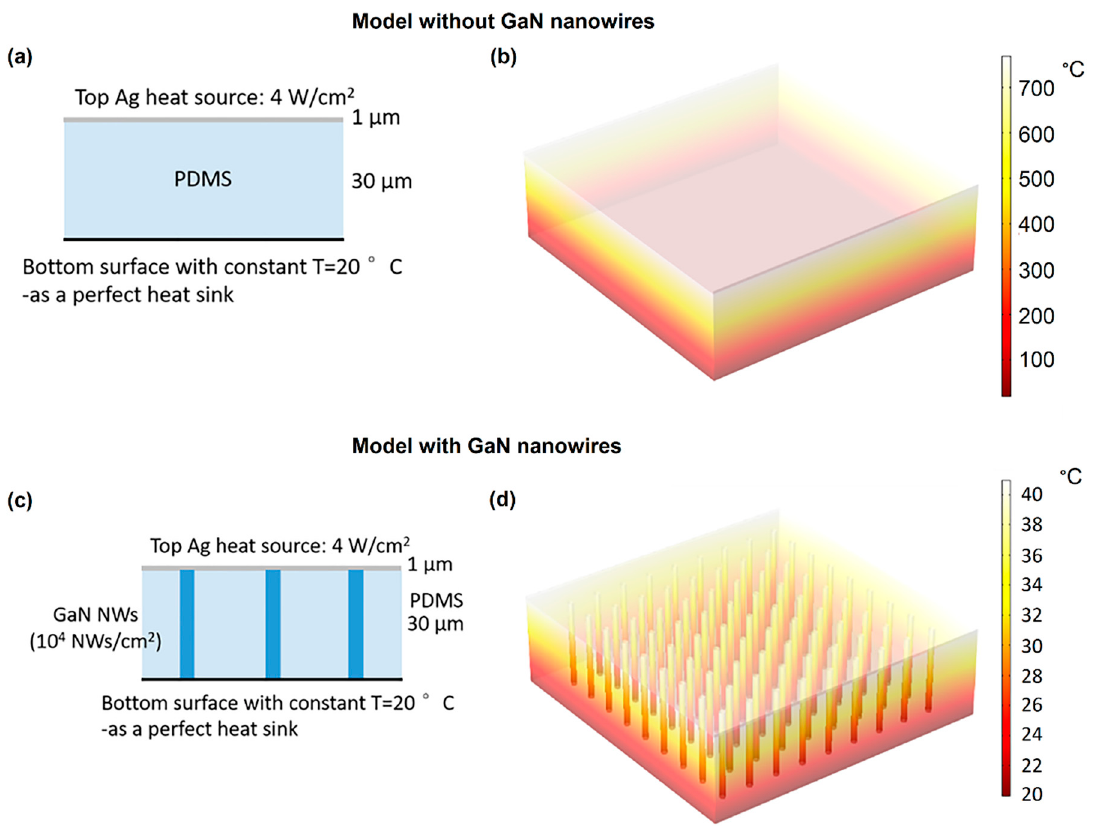
Figure 3. ( a ) Schematic of reference system without nitride NWs; ( b ) calculated temperature distribution in reference system; ( c ) schematic of flexible NW LED; ( d ) calculated temperature distribution in flexible NW